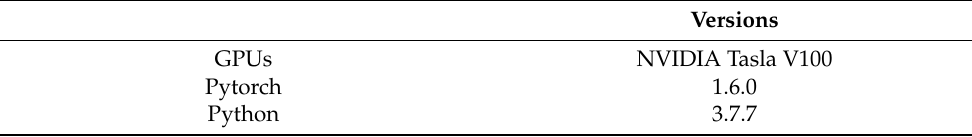
Table 3. The hardware and software of the experimental